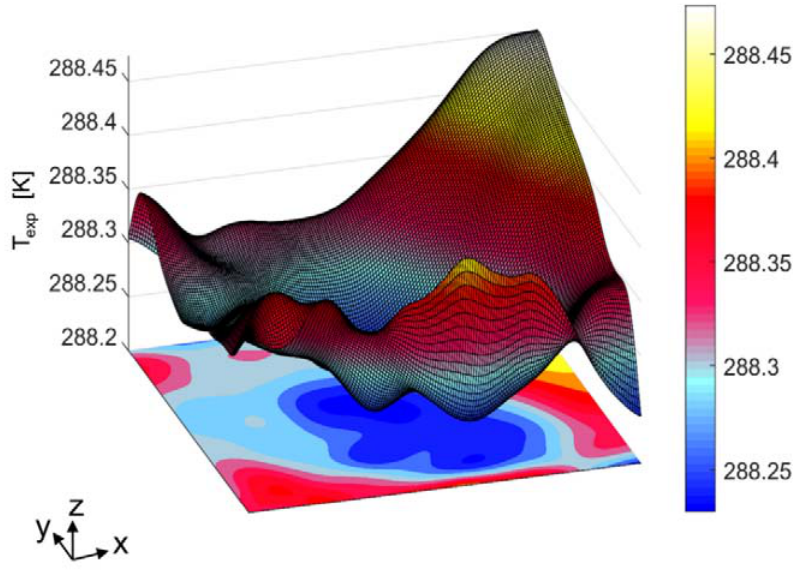
Figure 5: 3D rendering of the experimental thermal map on the specimen